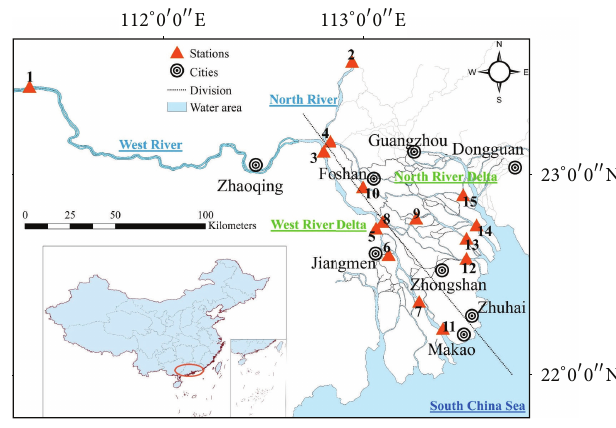
Figure 1: Map of Pearl River Delta and locations of gauging stations.